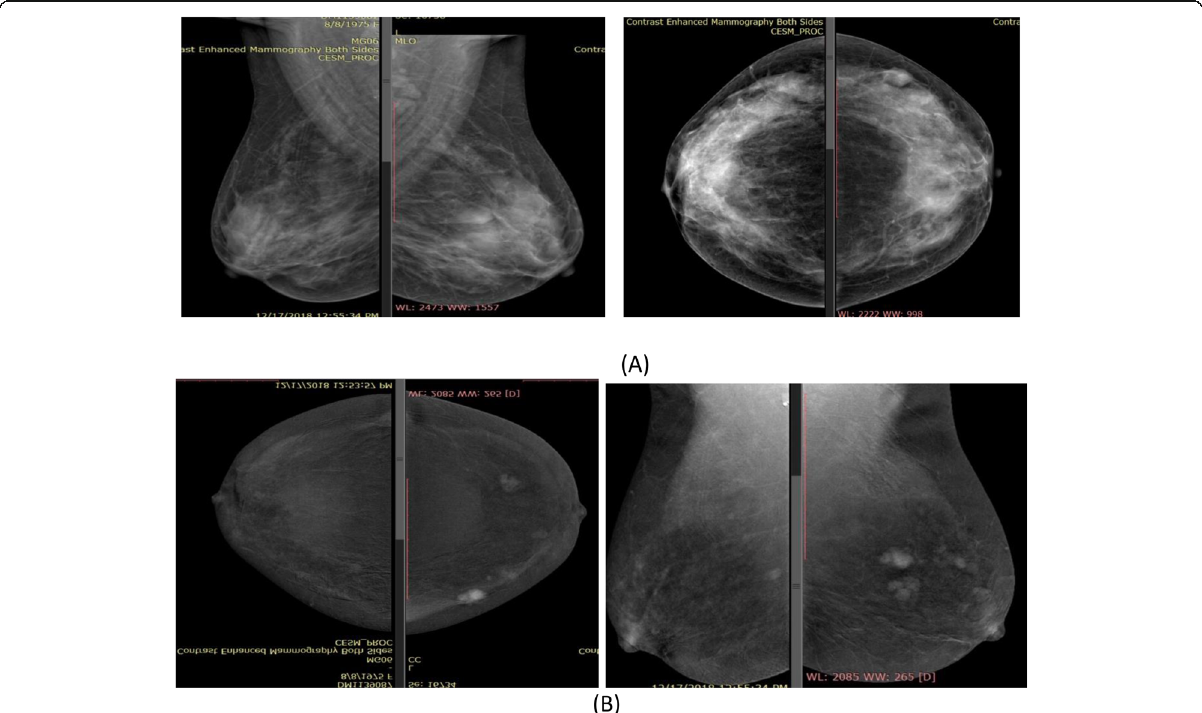
Fig. 1 44-year-old female with left palpable mass. A CC and MLO low-energy CESM images showed heterogenously dense breasts with asymmetric density seen at lateral left breast. B CC and MLO recombined images showed multiple bilateral enhancing lesions that were revealed to be fibrosclerotic tissue core with focal fibroadenomatous